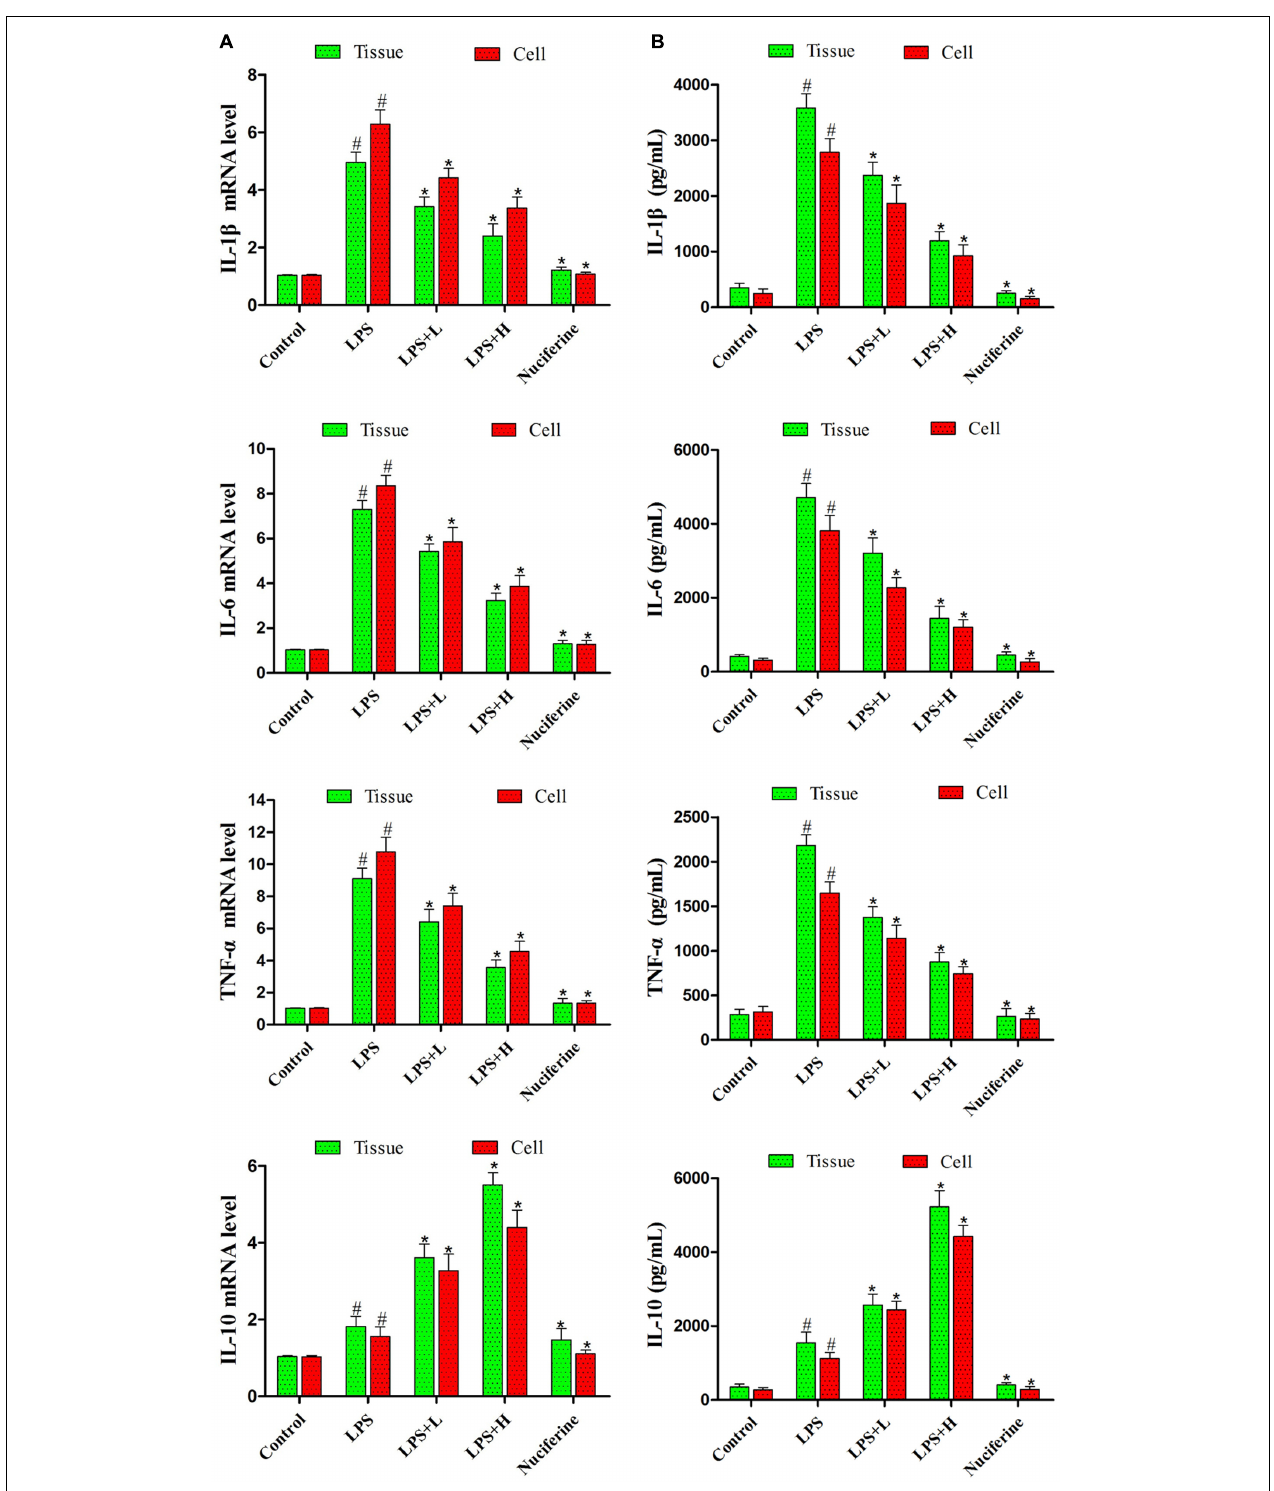
FIGURE 4 | Effects of nuciferine on the secretion of cytokines. (A) The level of cytokines TNF- α , IL-6, IL-1 β , and IL-10 mRNAs induced by LPS were detected qRT-PCR in tissues and cells. GAPDH served as the control. (B) The expressions of TNF- α , IL-6, IL-1 β , and IL-10 were detected using an ELISA kit in tissues and cells. L and H indicate the tissues treated with 10 and 20 mg/kg nuciferine, respectively, or the cells treated with 10 and 20 µ g/mL nuciferine, respectively. Data are represented as the mean ± SEM of three independent experiments. # p < 0.05 vs. Control group, ∗ p < 0.05 vs. LPS group.